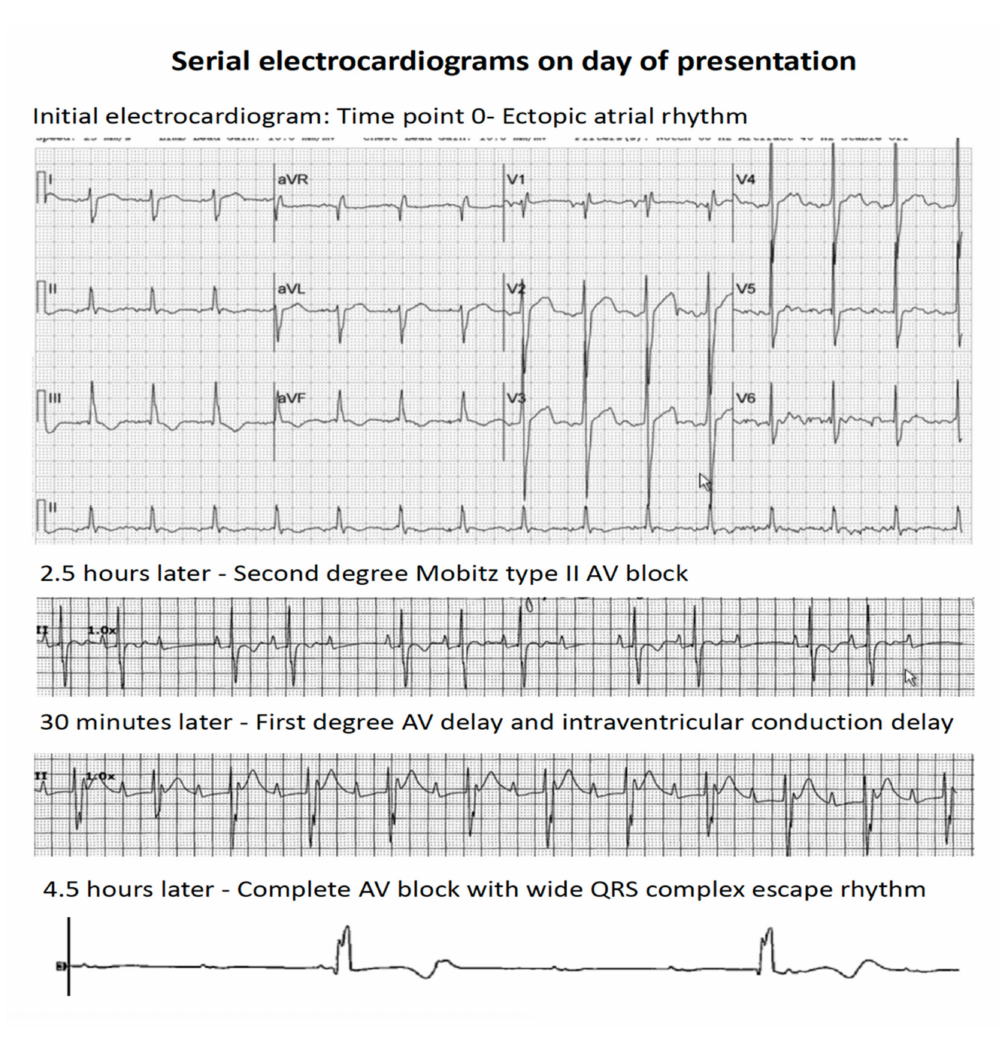
Figure 2. Serial electrocardiograms of the patient on the day of presentation demonstrating progres- sive AV conduction